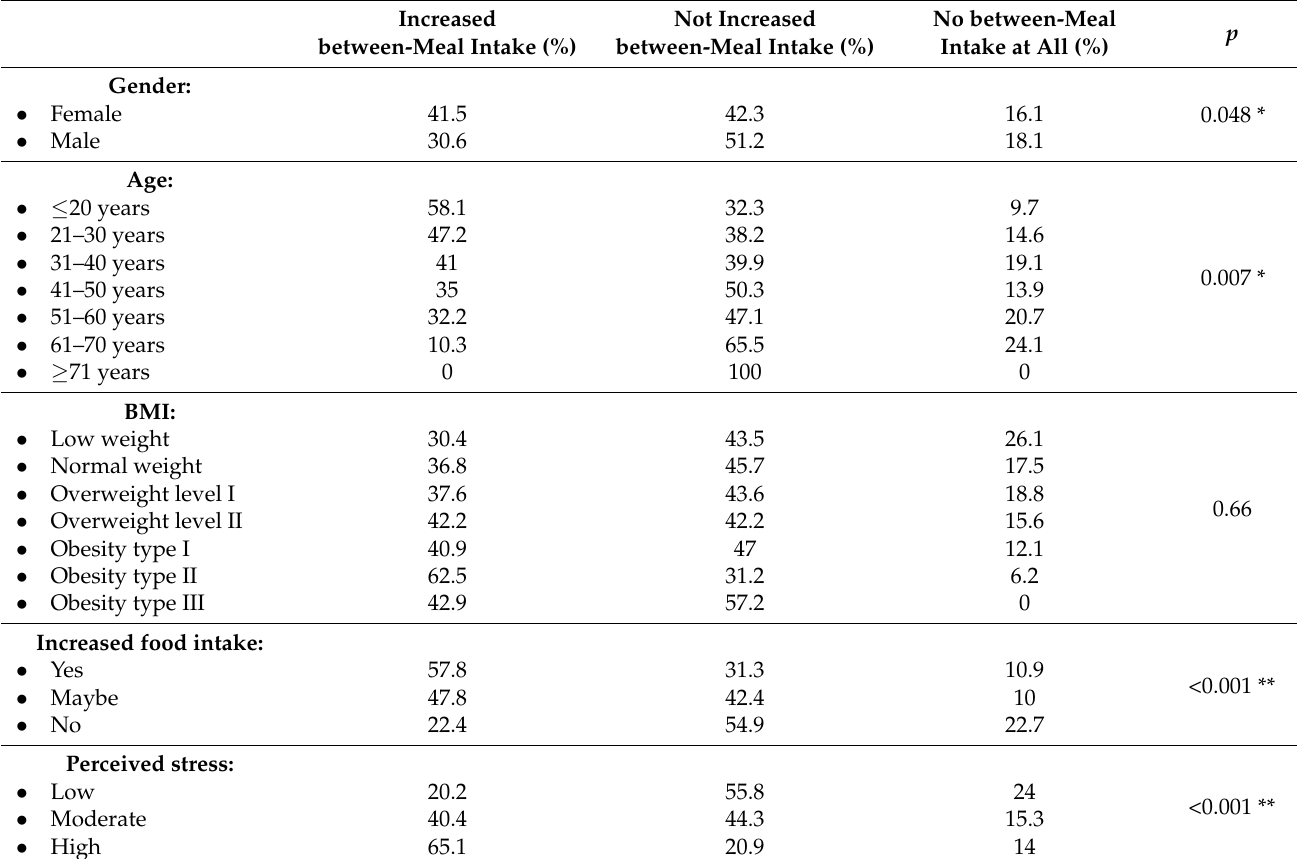
Table 5. Assessment of between-meal intake during the ‘third wave’ of the pandemic in Spain. Increased Not Increased No between-Meal between-Meal Intake (%) between-Meal Intake (%) Intake at All (%)